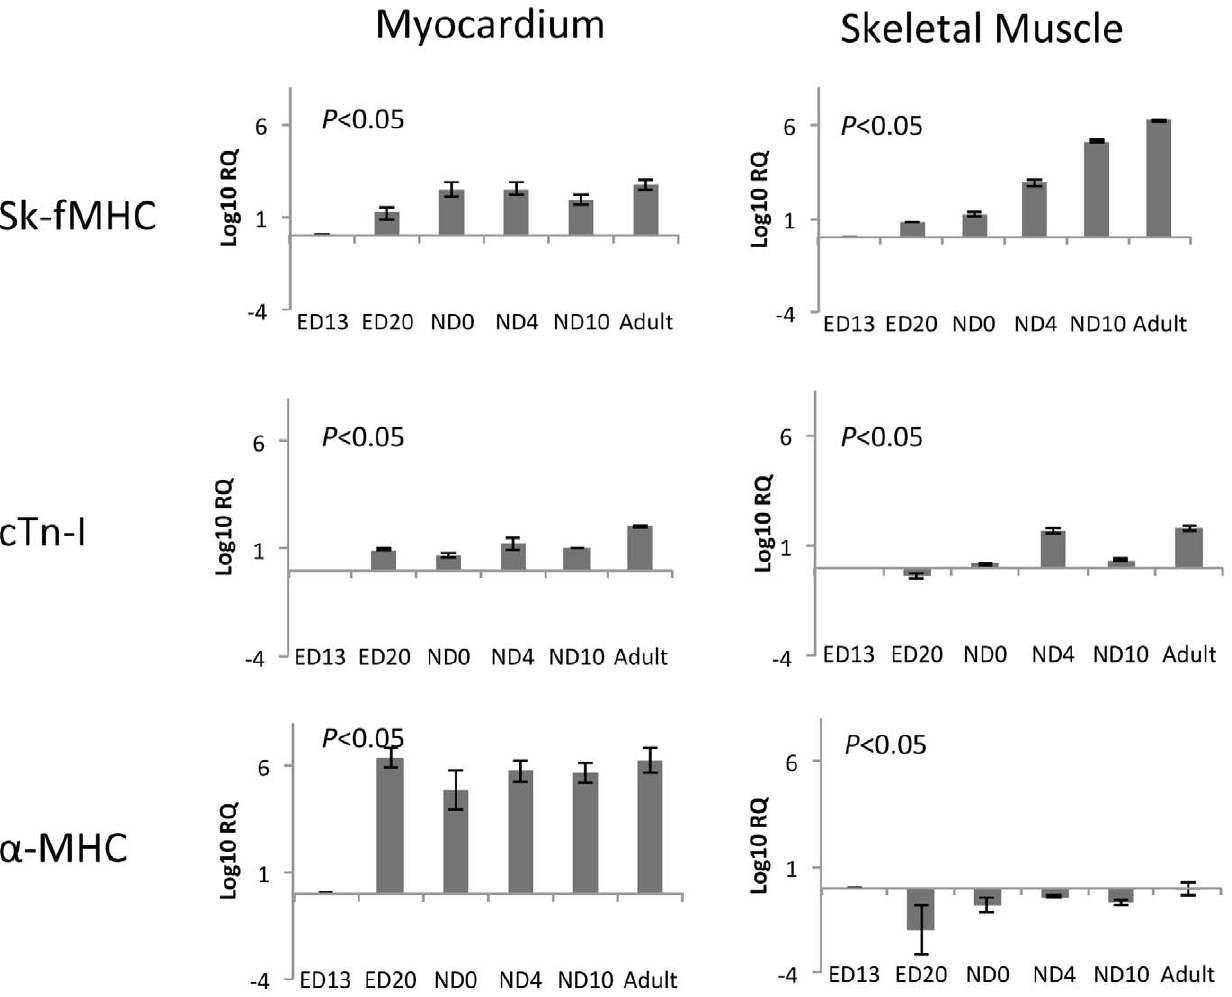
Figure 6. Changes in mRNA levels of sk-fMHC, cTn-I, and cardiac a -MHC within ventricular myocardium and skeletal muscle. Data are expressed as average 6 SD. The sk-fMHC mRNA level was significantly decreased and cTn-I and a -MHC levels were significantly increased in ventricular myocardium ( P , 0.05, ANOVA). Conversely, sk-fMHC mRNA level was significantly increased and cTn-I and a -MHC were significantly decreased in skeletal muscle. Log 10 RQ: Relative Quantification of mRNA level compared to the value in ED13. The ratio is expressed as logarithm with base value of 10 (Log 10 ).